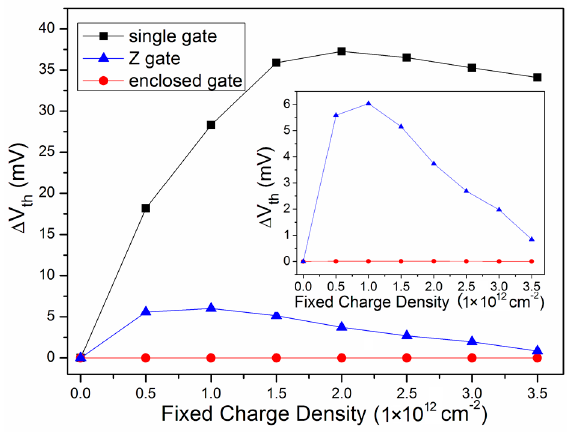
Figure 3. The threshold voltage shift of the three layouts at different charge densities.